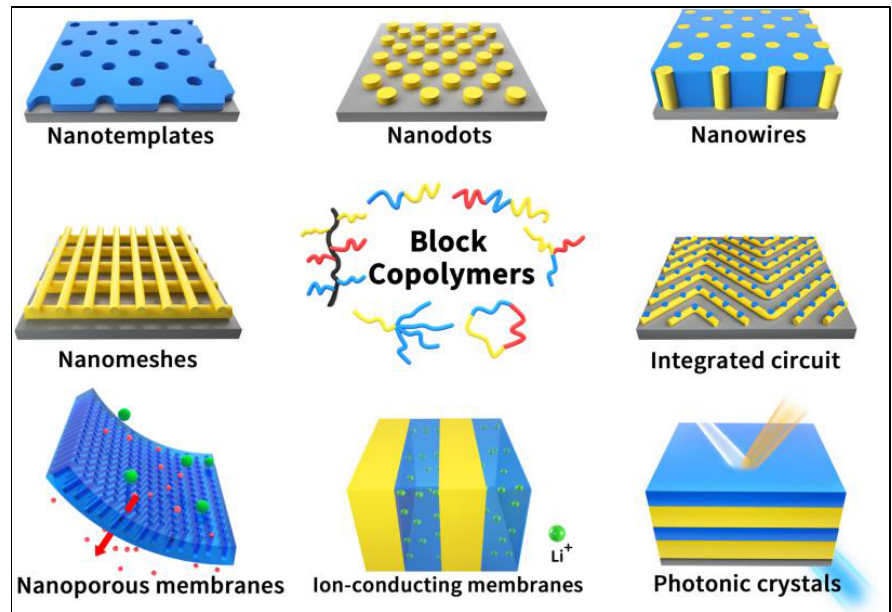
Figure 7. Self-assembled films and membranes from BCP. Schematic representation of nanopat- terned systems enabled by BCP phase separation [219].